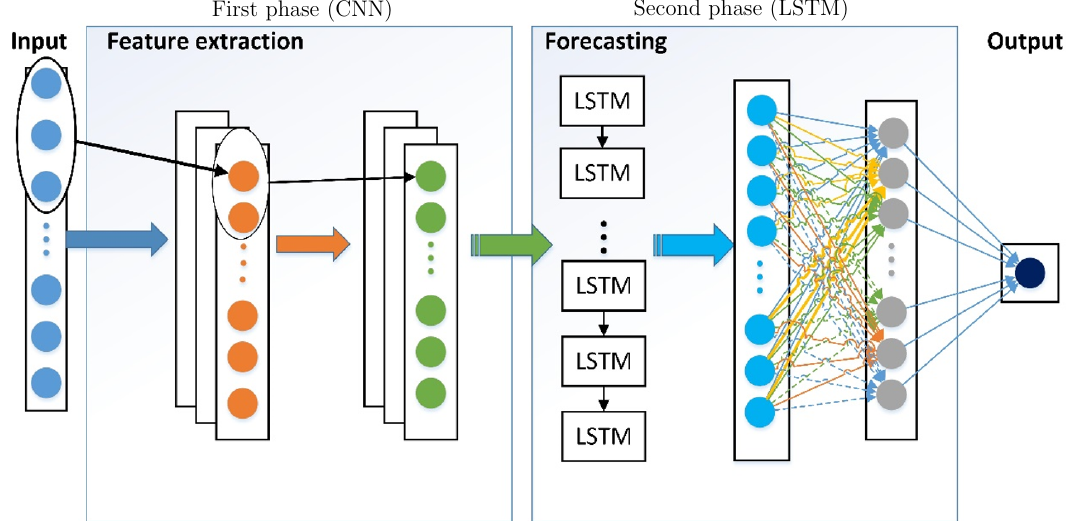
Figure 2. The proposed hybrid DNN power consumption forecasting